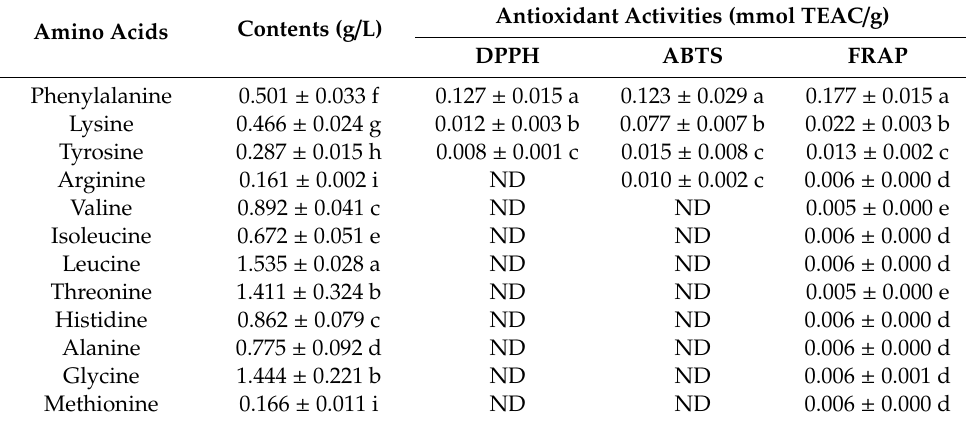
Table 3. Amino acids contents and antioxidant activities in ZAV-5 1,2,3